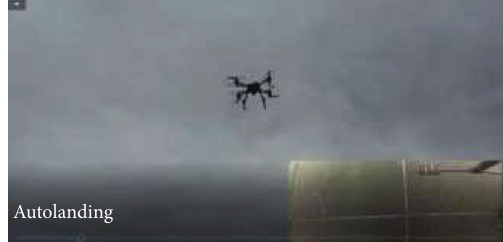
Autolanding Figure 13: Trial VTOL for the